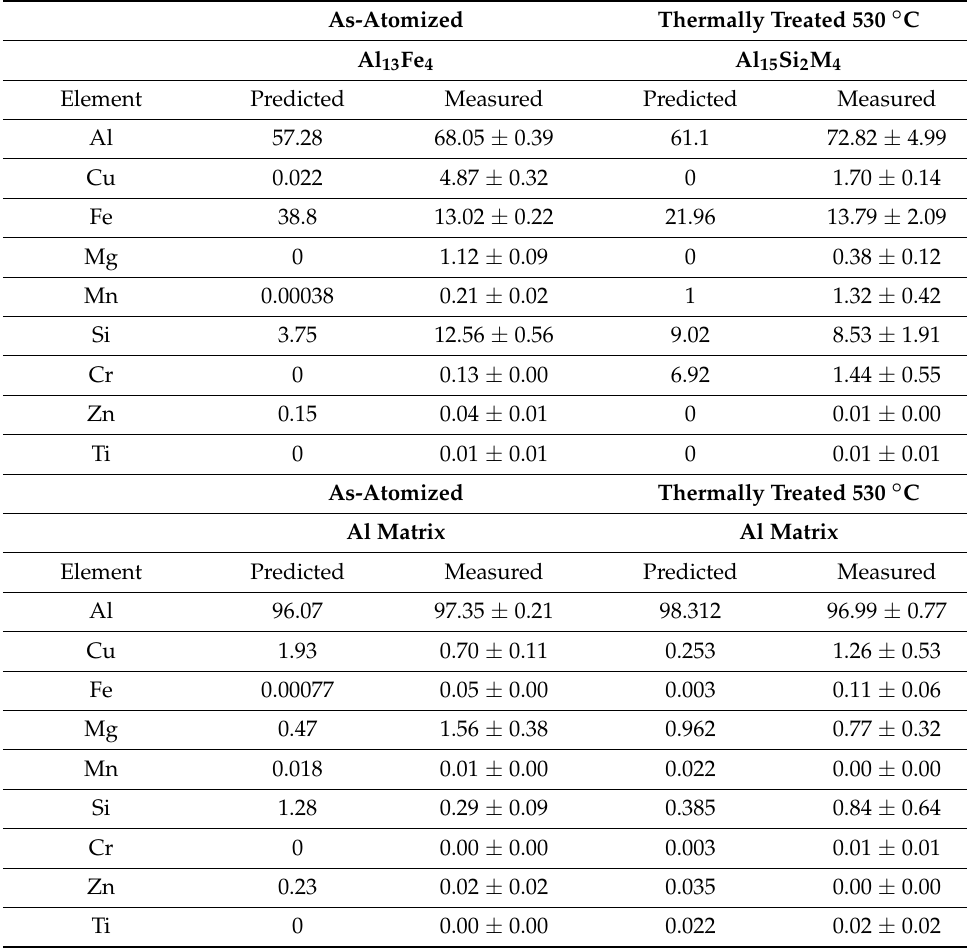
Table 3. Phase compositions (in wt. %) as calculated by TEM point EDS and as predicted by ThermoCalc for the as-atomized and thermally treated conditions.